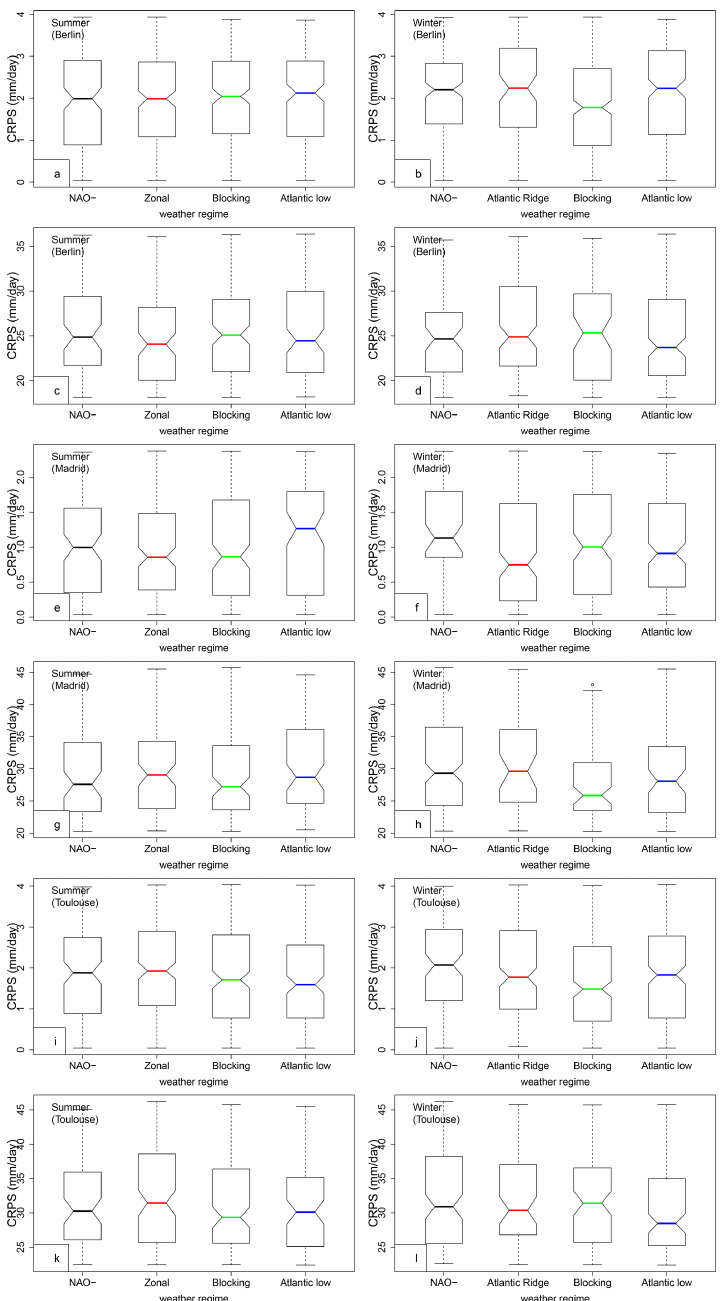
Figure A1. Relation between CRPS and weather regimes for Berlin (a–d) , Madrid (e–h) , and Toulouse (i–l) , for SWG forecasts with lead time T = 5d. Panels (a) , (b) , (e) , (f) , (i) , and (j) correspond to CRPS value distribution conditioned on four weather regimes, when CRPS is lower than q 25 . Panels (c) , (d) , (g) , (h) , (k) , and (l) correspond to a higher CRPS value (CRPS ≥ q 75 ). The boxplots indicate the median ( q 50 ) of the distribution (thick